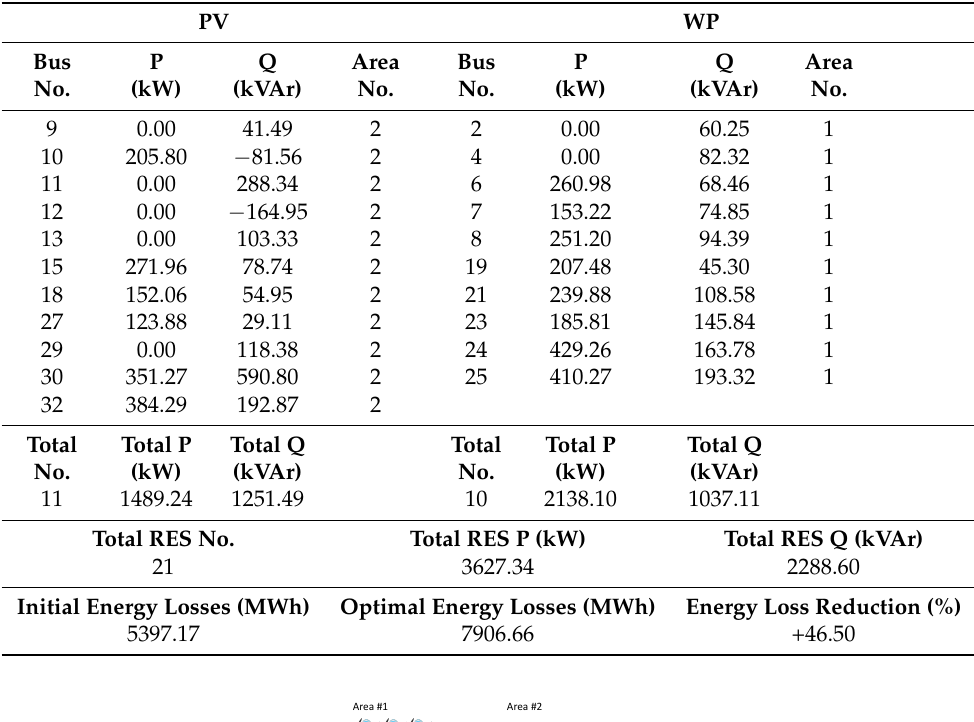
Figure 22. Snapshot Approach—Max Value—Scenario #1 solution. Table 13. Snapshot approach—Max Value—Scenario #2.